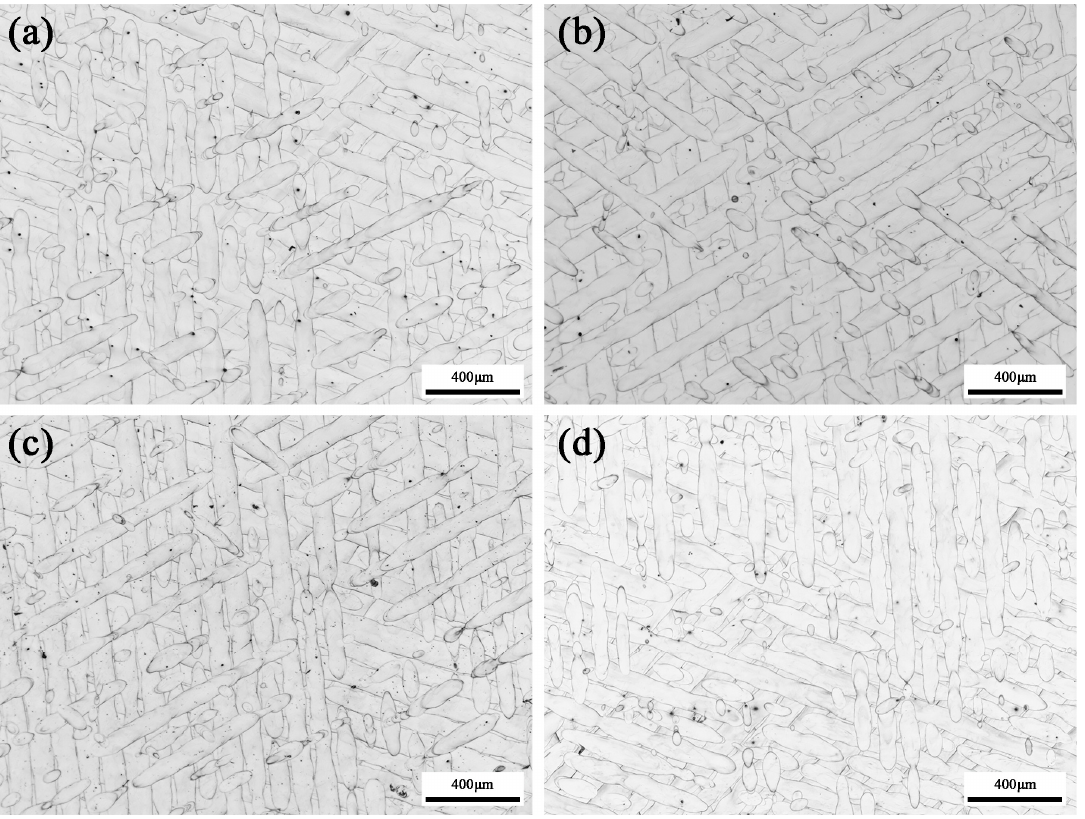
Figure 2. Light optical microstructure of SLM-fabricated Ti-22Al-25Nb: ( a ) S1, ( b ) S2, ( c ) S3, and ( d ) S4.